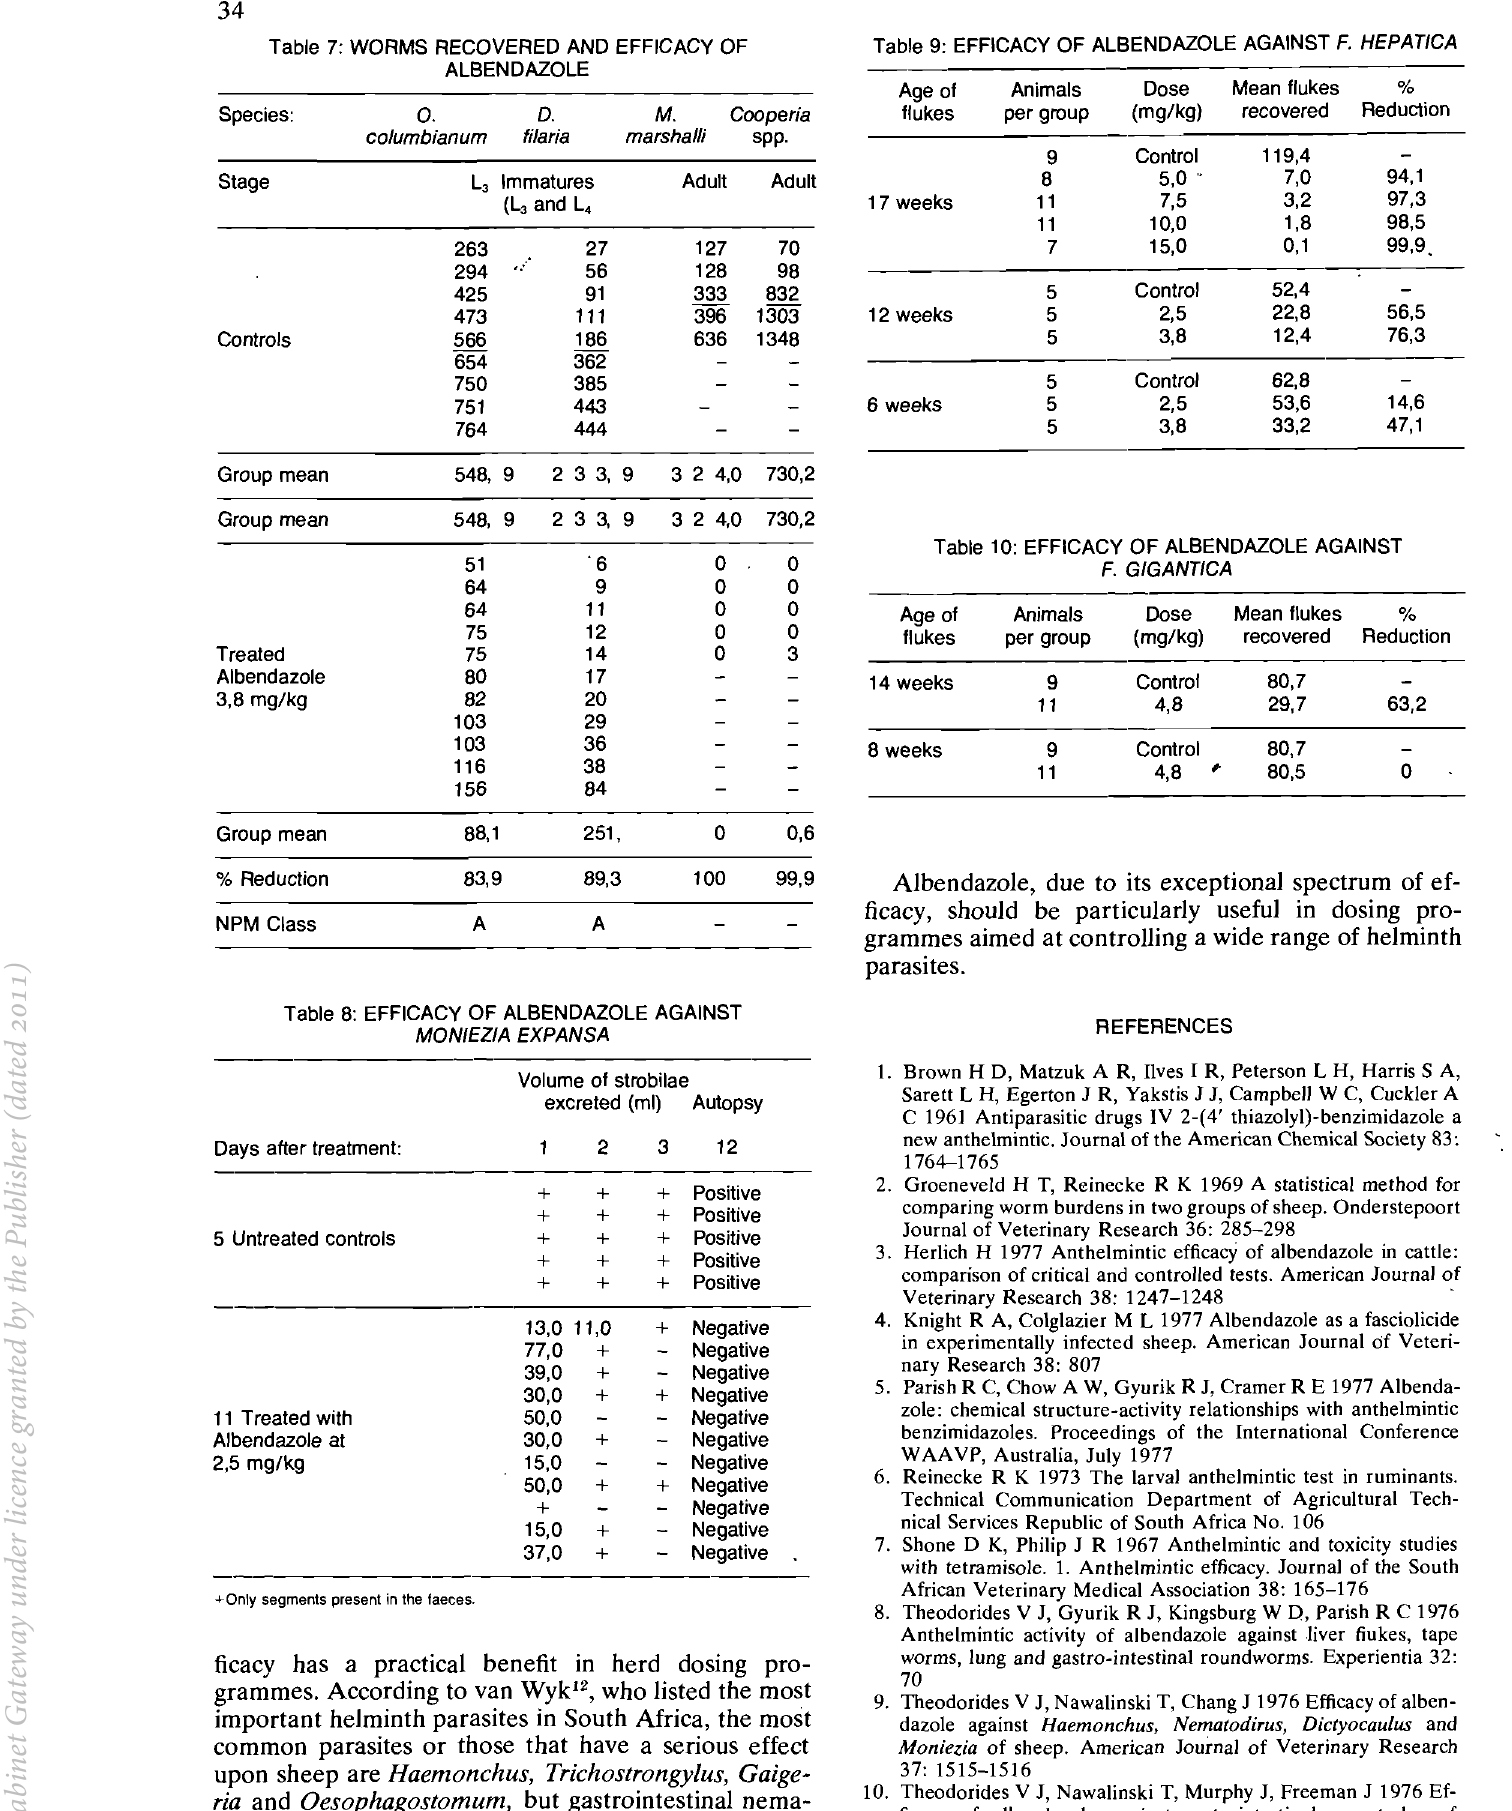
Table 9: EFFICACY OF ALBENDAZOLE AGAINST F. HEPATICA